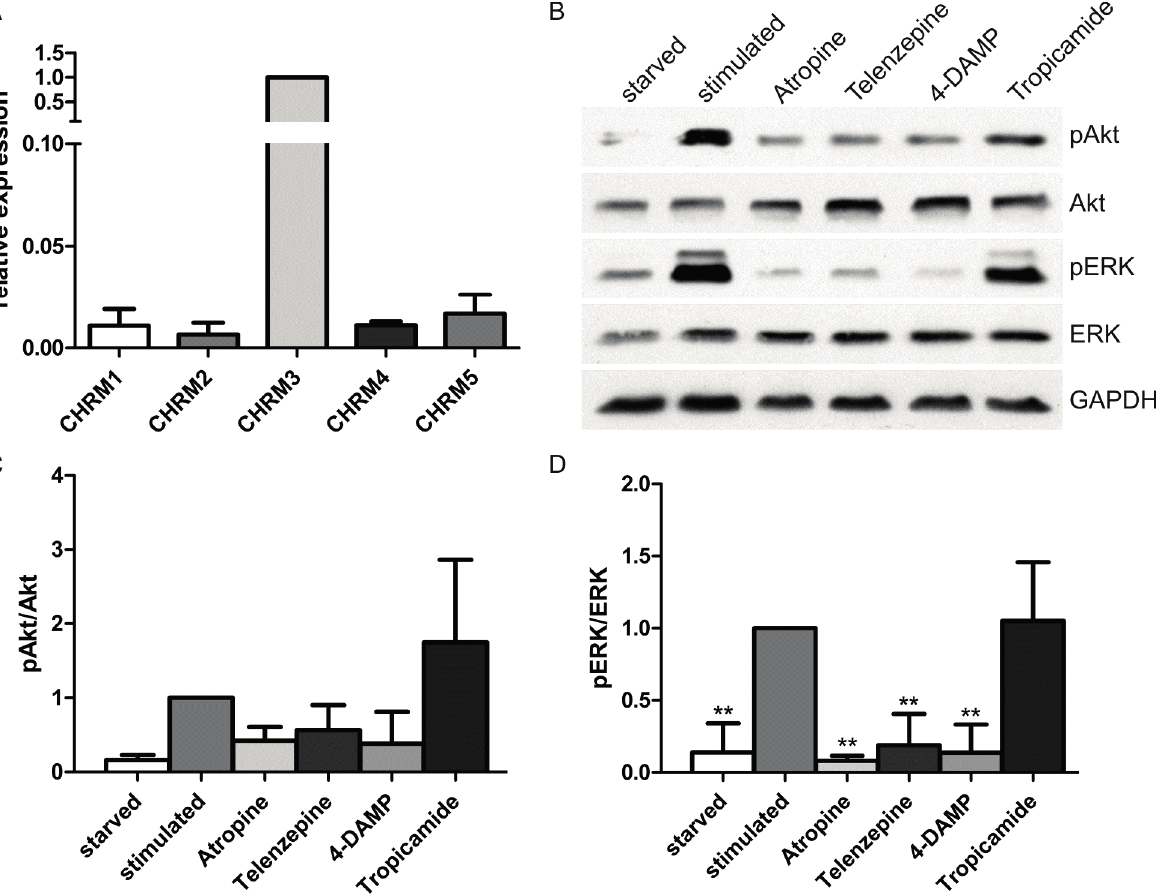
Figure 2. Inhibition of M 1 and M 3 receptors prevents cholinergic activation of ERK. ( A ) The expression of the muscarinic receptor subtypes on mRNA level in HaCaT cells was studied using RT-qPCR; ( B ) Serum-starved HaCaT cells were pretreated with mAChR inhibitors for 30 min and then stimulated with 1 mM CCh for 30 min in the presence of the inhibitors. M 1 was inhibited with 10 µM telenzepine, M 3 with 10 µM 4-DAMP and M 4 with 10 µM tropicamide. As a control, 25 µM atropine was used to inhibit all muscarinic receptors. Equal amounts of cell lysates were separated by SDS-PAGE and immunoblotted; ( C , D ) The amount of pAkt and pERK was determined by densitometric quantification and normalized to total Akt or ERK. Data are shown relative to CCh stimulated cells. Bars represent the mean ± SD of three independent experiments. Statistical analysis was performed with one-way ANOVA; ** p <